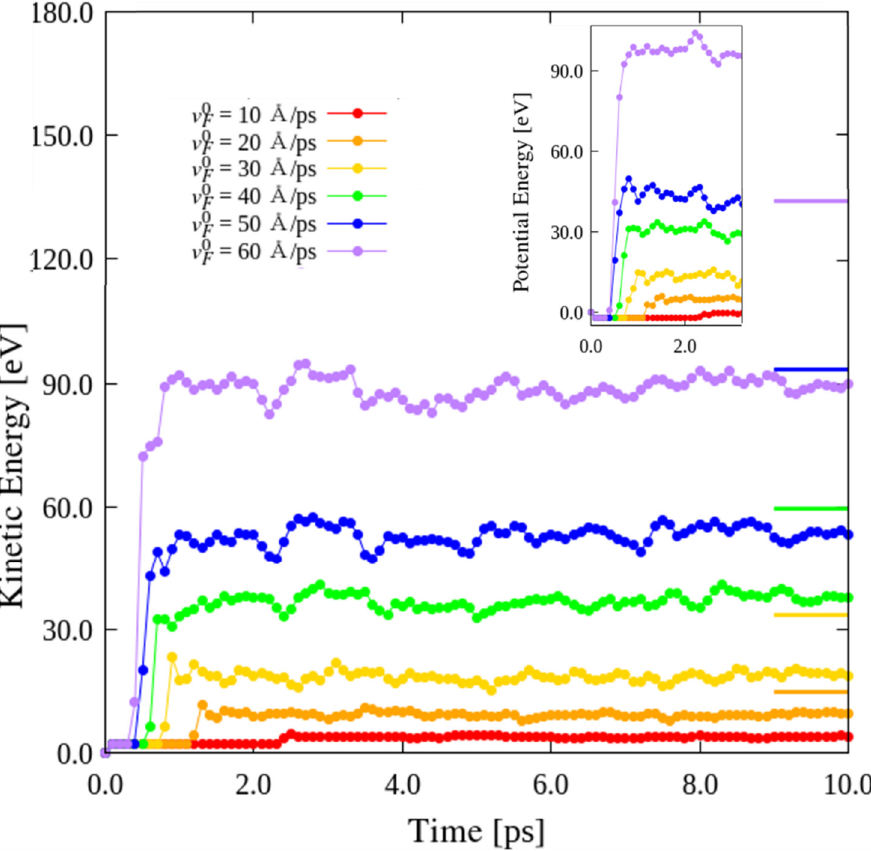
Figure 7. Comparison of KEs of wavy4 GS impacted by C 60 with impact velocities 𝑣 (cid:2890)(cid:2868) = 10, 20, 30, 40, 50, and 60 Å/ps at A4.